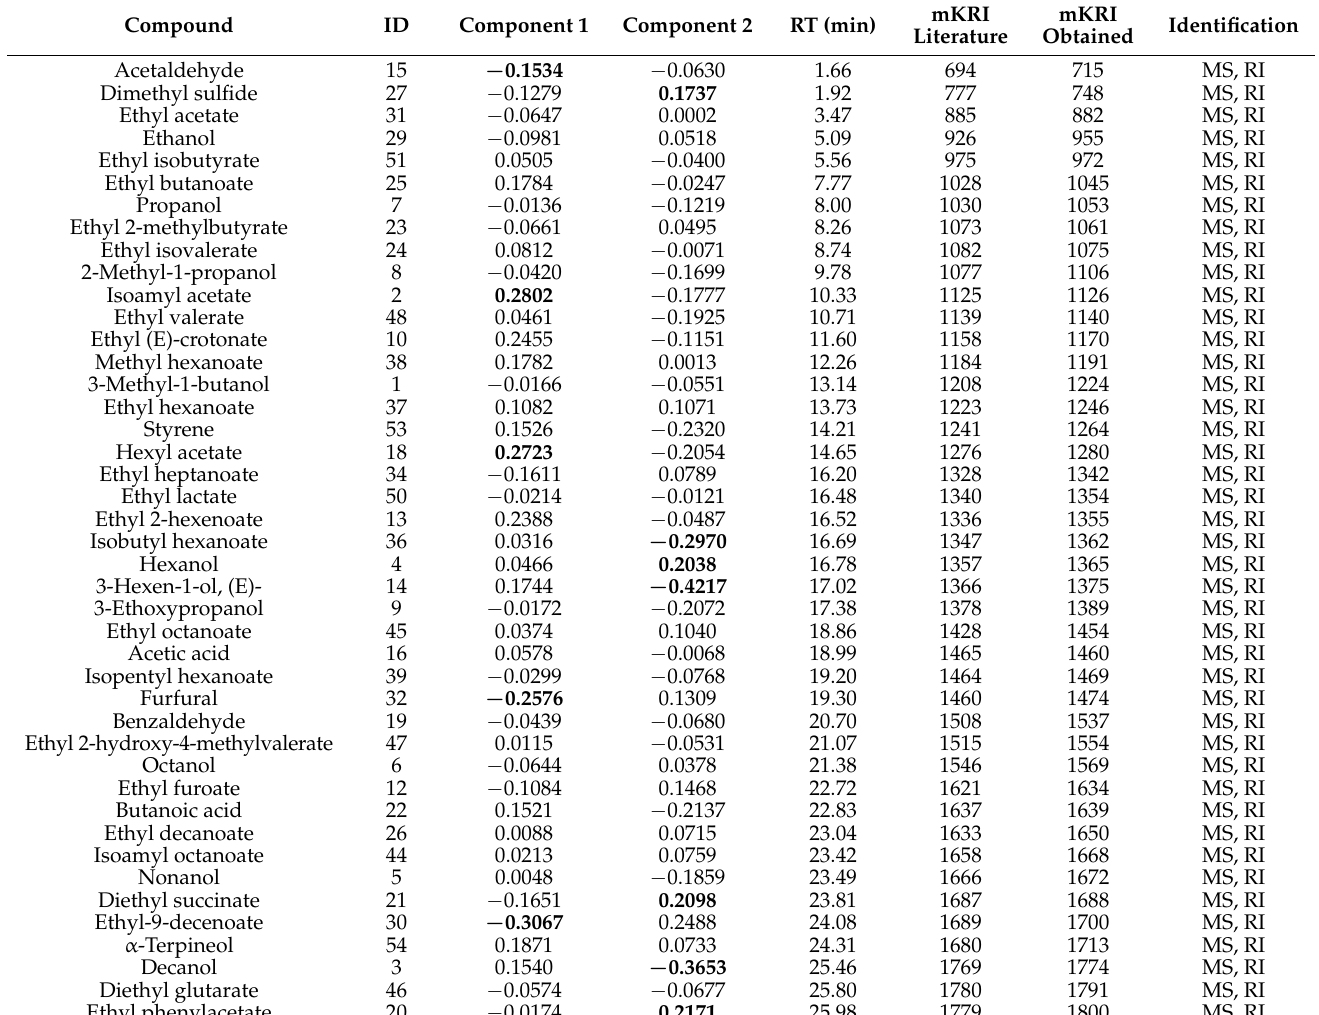
Table 1. Compounds identified for both training systems and seasons in a replicate of vinifications of Chardonnay grapes harvested in the southeast of Brazil (Caldas, Minas Gerais), with the following features: compound identification (ID), loading of each compound for components 1 and 2, retention time (RT), modified Kovats retention indeces (mKRI) from the literature and obtained, and the identification